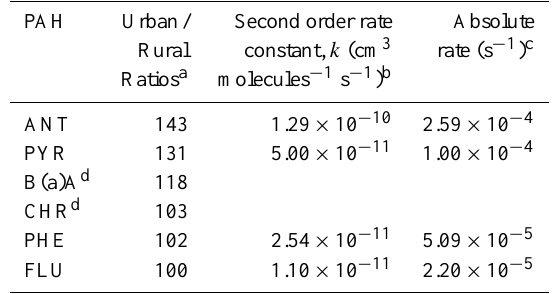
a Urban / rural ratios calculated using remote air mass rural data (see Fig. 4, red bars). b Average second order rate coefficient calculated from NIST kinetics database,